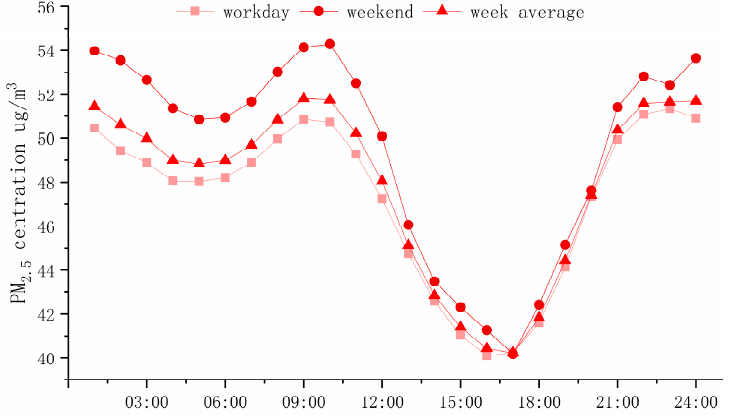
Figure 3. Daily variation trend of PM 2.5 concentration in 2017.